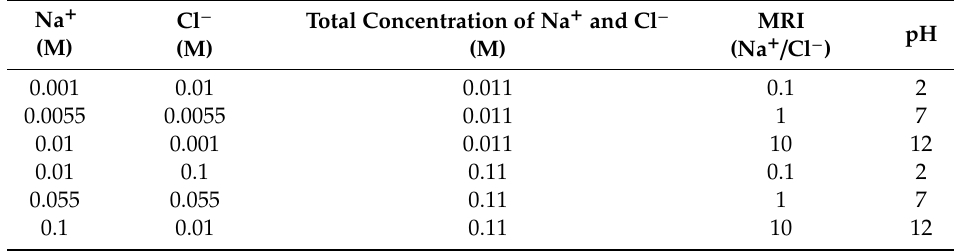
Table 3. Experimental conditions for the electrochemical corrosion